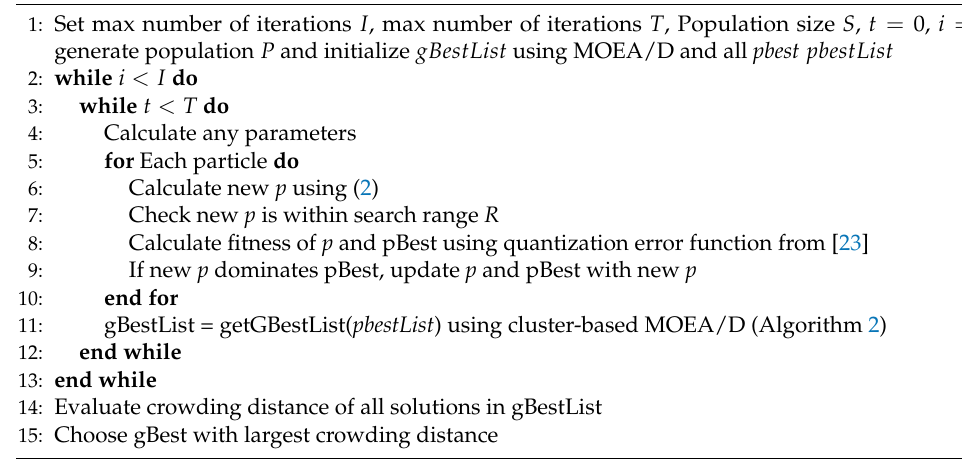
Algorithm 1 Pseudocode for BBPSO